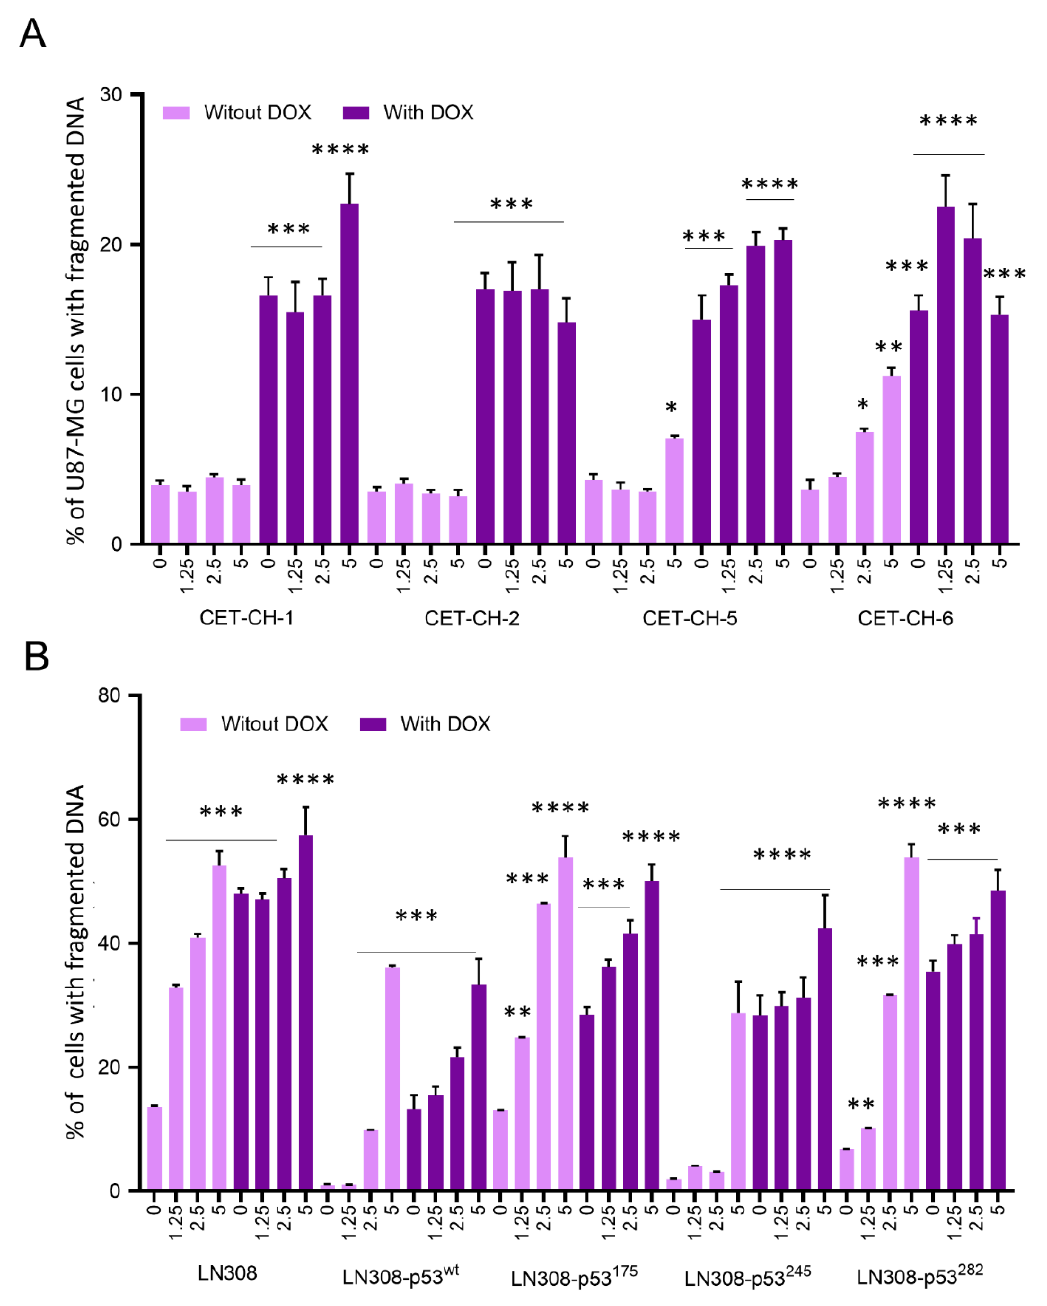
Figure 5. U87-MG cells with wt-p53 expression tested for therapeutic outcome in response to the treatment of Nrf2 activators and inhibitors in the presence and absence of DOX. ( A ) fixed cell population assessed by PI staining based FACS after treatment of U87-MG-p53 wt by DOX (0.05 µ M) in the presence of two Nrf2 activators (CET-CH-1 and CET-CH-2) and two Nrf2 inhibitors (CET-CH-5 and CET-CH-6), the gating results are shown in Figure S5; ( B ) fixed cell population assessed by PI staining based FACS after treatment of LN308 cells stably expressing different p53 mutations with DOX (0.05 µ M) in the presence of CET-CH-6 (concentrations in µ M), the gating results are shown in Figure S6. Experiments were performed three times. Cells with fragmented DNA, late apoptotic population, show diffused PI staining compared to non-apoptotic cells. Error bars represent mean ± SD. *, **, ***, **** markers above the columns represent p -value < 0.05, <0.01, <0.001, <0.0001, respectively. Each sample is compared to non-treated control sample of the same cell line.